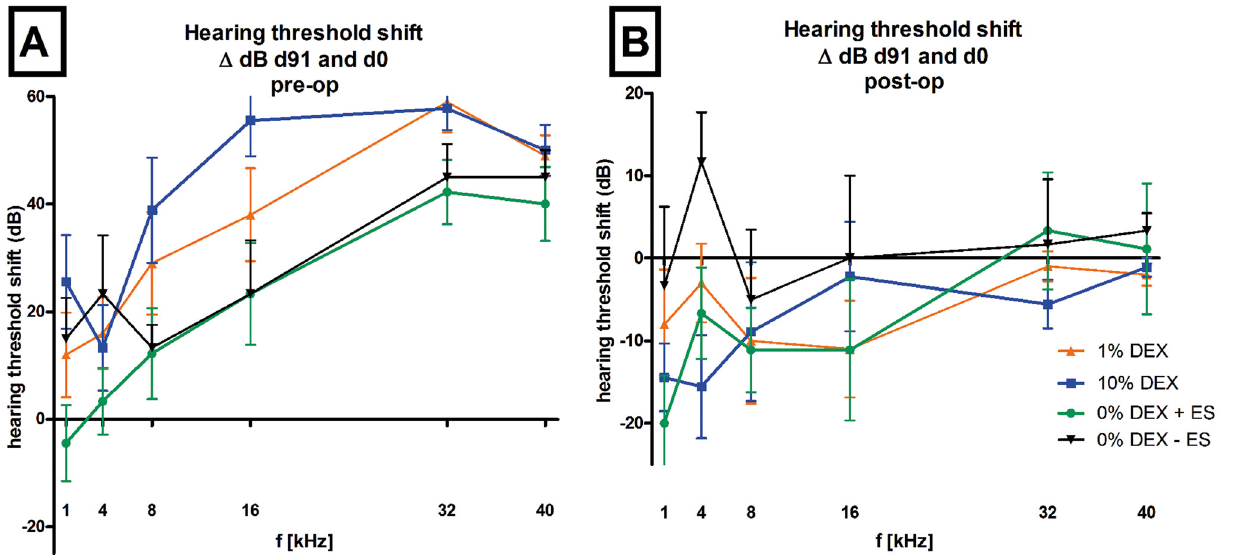
Fig 8. Shifts in hearing thresholds obtained on day 0 before (A) and after surgery (B) until day 91 are plotted ( Δ dB) for all tested frequencies. At 4, 8, 32 and 40 kHz no differences in Δ dB between treatment groups were observed for day 0 (pre-operative) and day 91. 10% DEX treatment resulted in significantly greater threshold shifts at 1 and 16 kHz than 0% DEX + ES (p < 0.05) or 0% DEX without-ES at 16 kHz (p < 0.05) (A). No differences between groups where observed when relating the final threshold (day 91) to the day 0 threshold measured after surgery (B). Error bars: